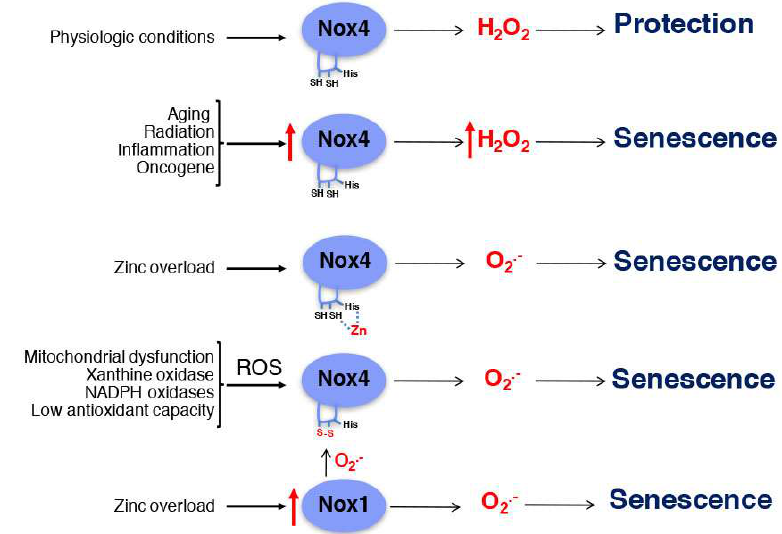
Figure 4. Proposed role of Nox1 and Nox4 in senescence. Hydrogen peroxide associated with basal Nox4 activity in physiological conditions protects from senescence, while overproduction of hydrogen peroxide during aging and stress conditions may promote senescence. Binding of zinc to the E-loop of Nox4 or oxidation of cysteine residues in the E-loop in response to stress conditions by overexpression of Nox1 could change the function of Nox4. Altered production of superoxide by Nox4 could mediate senescence in conditions of stress. Red arrows indicate increased expression.